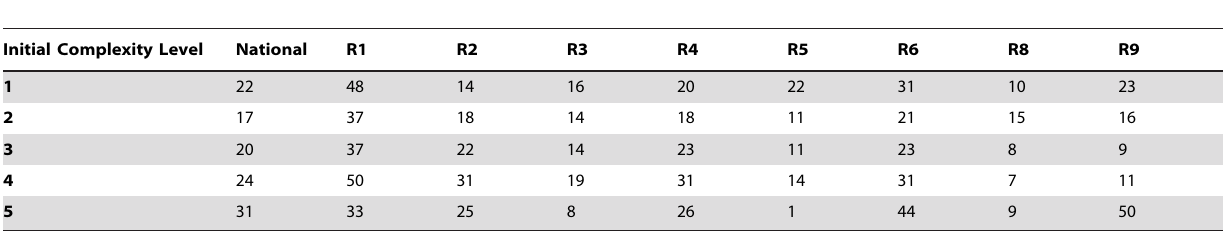
Table 7. Expected time until containment for a fire that starts at a given complexity level, presented for National and Regional scales.